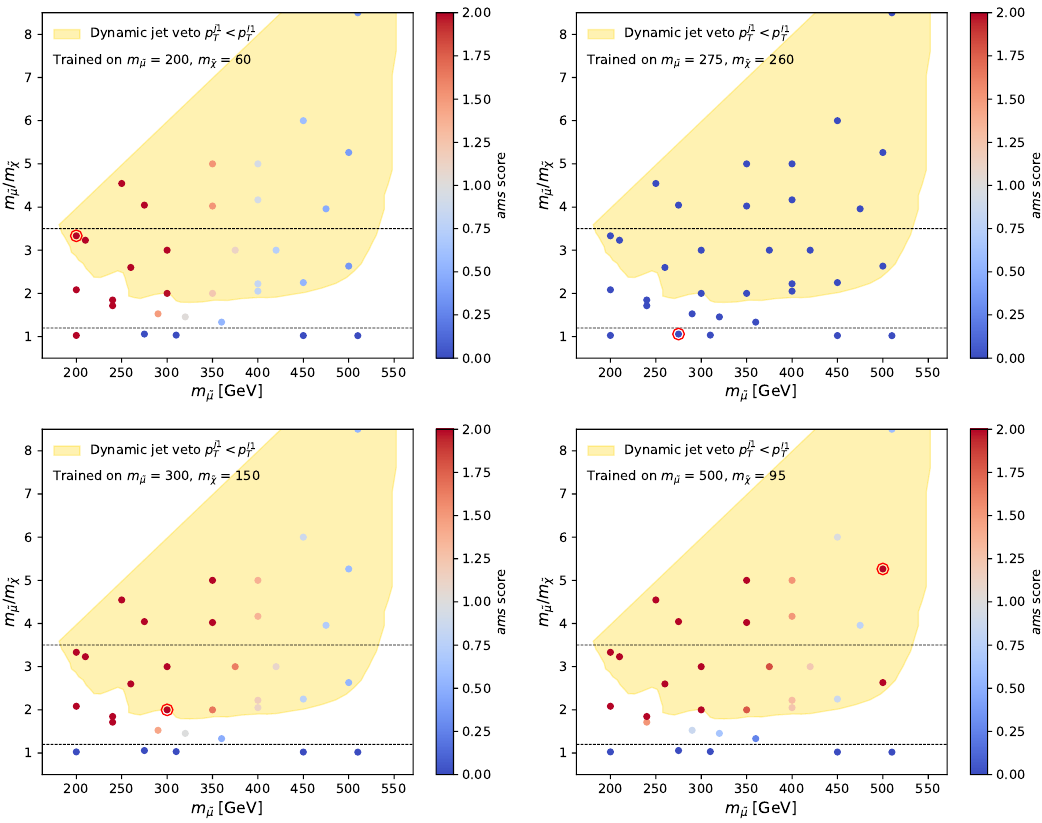
Figure 7 . Good performance of a model trained on a specific benchmark is presented, where the training mass point is circled in red. The shaded yellow region corresponds to the 95% CL exclusion obtained using the dynamic jet veto in ref. [29]. The designation of the mass regimes in given by the dashed black horizontal lines. Points considered are randomly